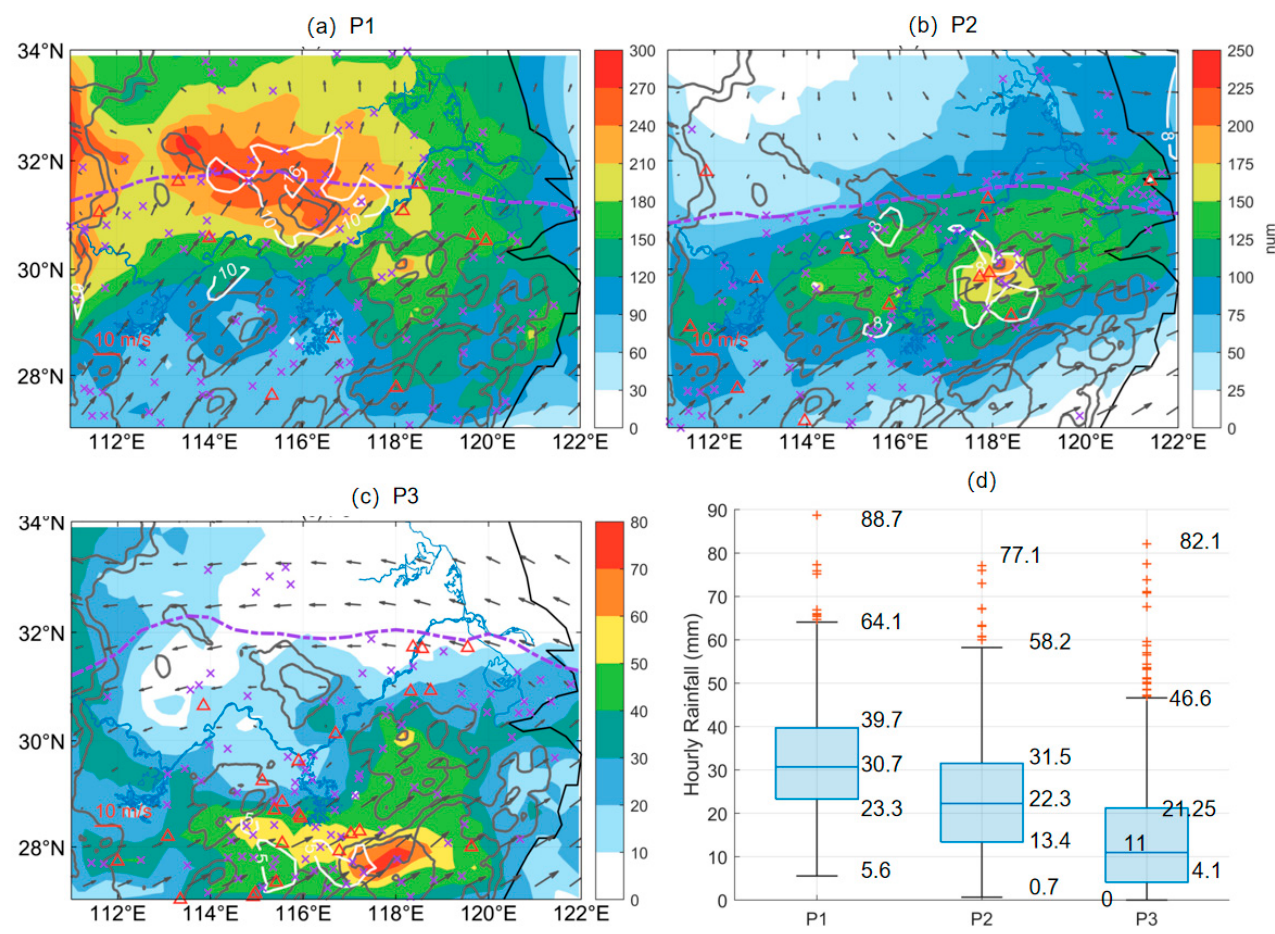
Figure 11. The hourly rainfall frequency (shadings; unit: num) obtained from the R1m dataset, the mean horizontal wind vectors, and the mean location of the Meiyu front, marked by purple dashed lines, as defined by the maximum gradient of the equivalent potential temperature at 850 hPa, under the synoptic patterns of ( a ) P1; ( b ) P2; and ( c ) P3 during June–July 2020. The white solid contours indicate centers of heavy hourly rainfall frequency ( ≥ 15 mm h − 1 ) with a value of 10 counts, 8 counts, and 5 counts under P1, P2, and P3, respectively. Rain gauges that record hourly rainfall rates over the threshold of the 25th quantile and the maximum outlier under each pattern are labeled by purple crosses and red triangles, respectively. ( d ) This is similar to Figure 3c but for the maximum hourly rainfall at national rain gauges under the synoptic patterns of P1, P2, and P3.